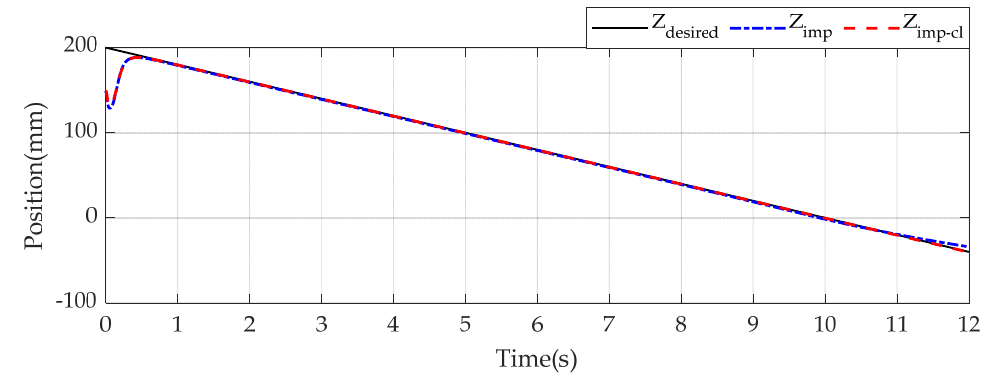
Figure 8. Position tracking effort along the Z-direction.